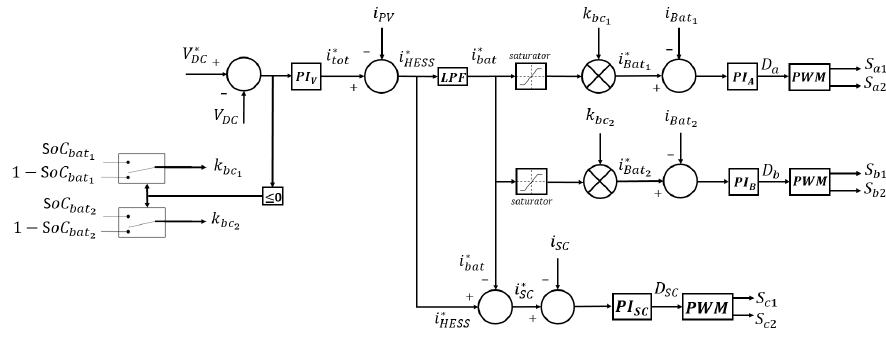
Figure 5. FBM-CSoC control loop structure.